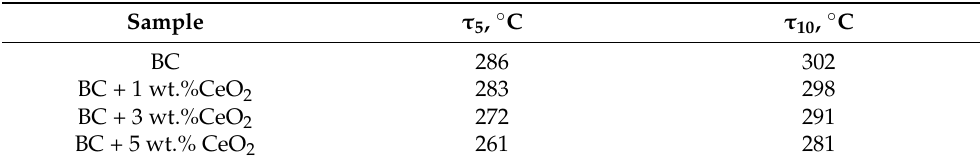
Table 1. Thermal stability indices of the BC and BC-ceria nanocomposite films.